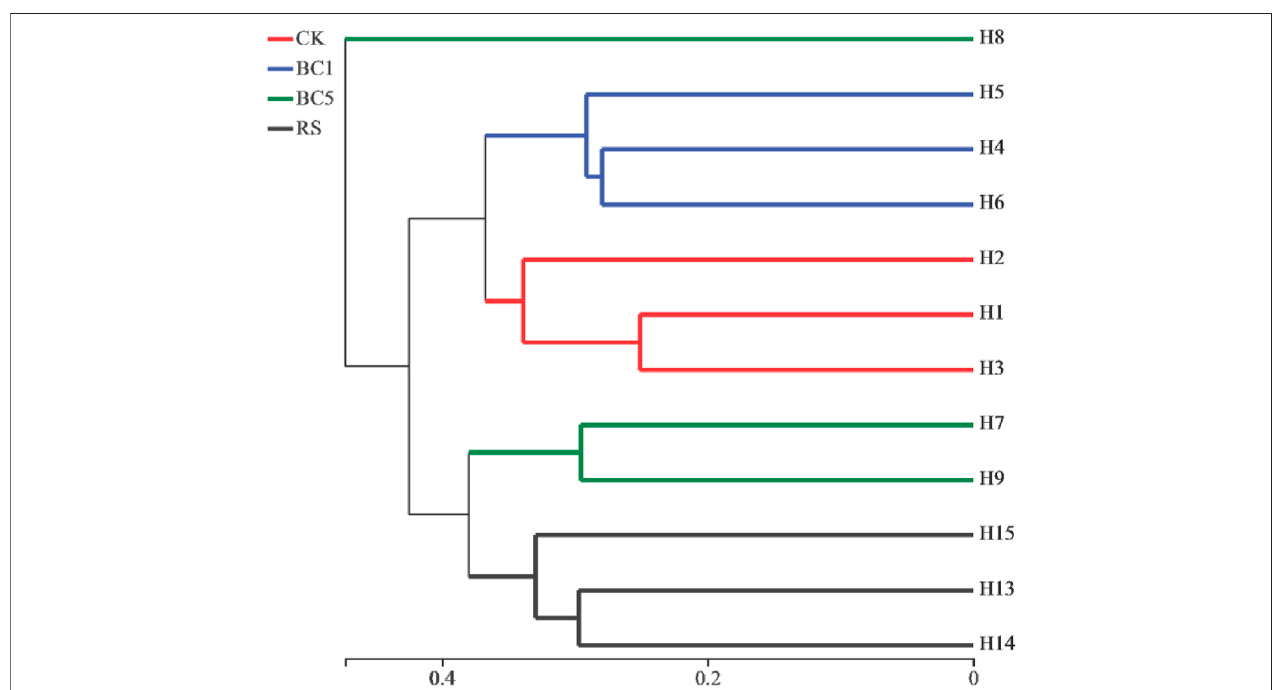
FIGURE 1 | Similarity cluster analysis of multiple copies. H indicates different soils.